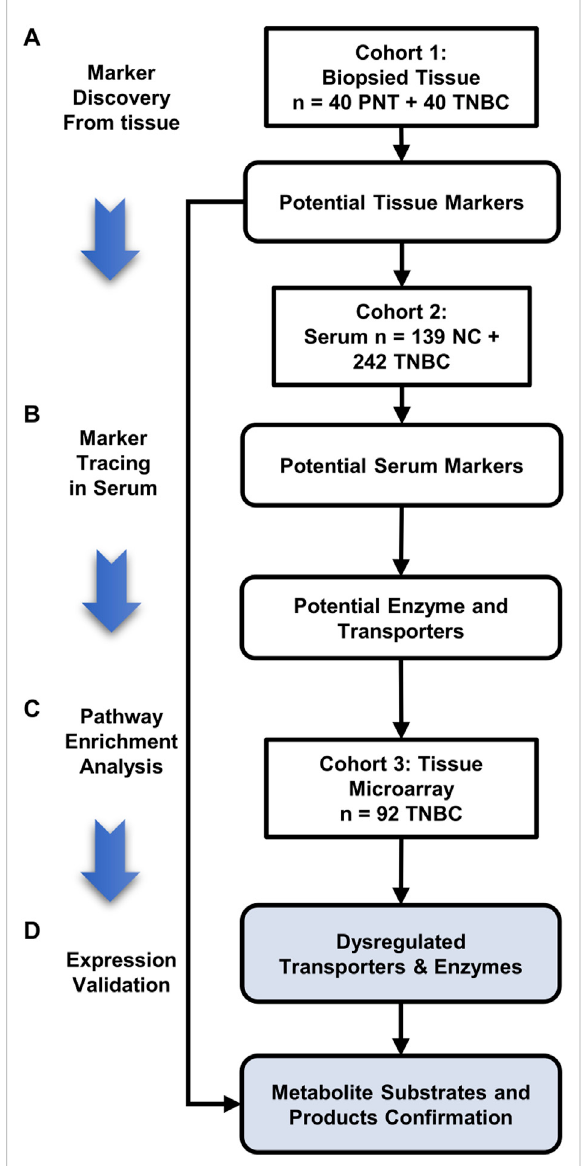
FIGURE 1 Three stages of this TNBC tissue-serum joint metabolomics work fl ow. (A) Markerdiscoveryfrombiopsiedtissue:240sampling points collected from 40 pairs of TNBC and PNT tissues are